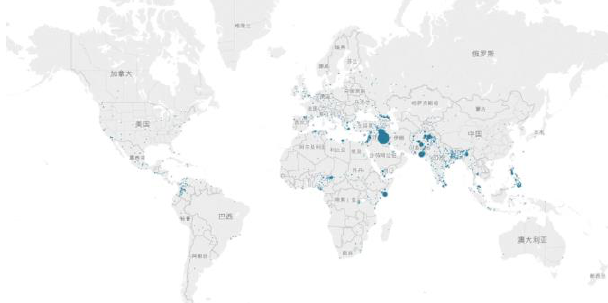
Figure 8 Pie chart of terrorism events that happened throughout the world from 2006 to